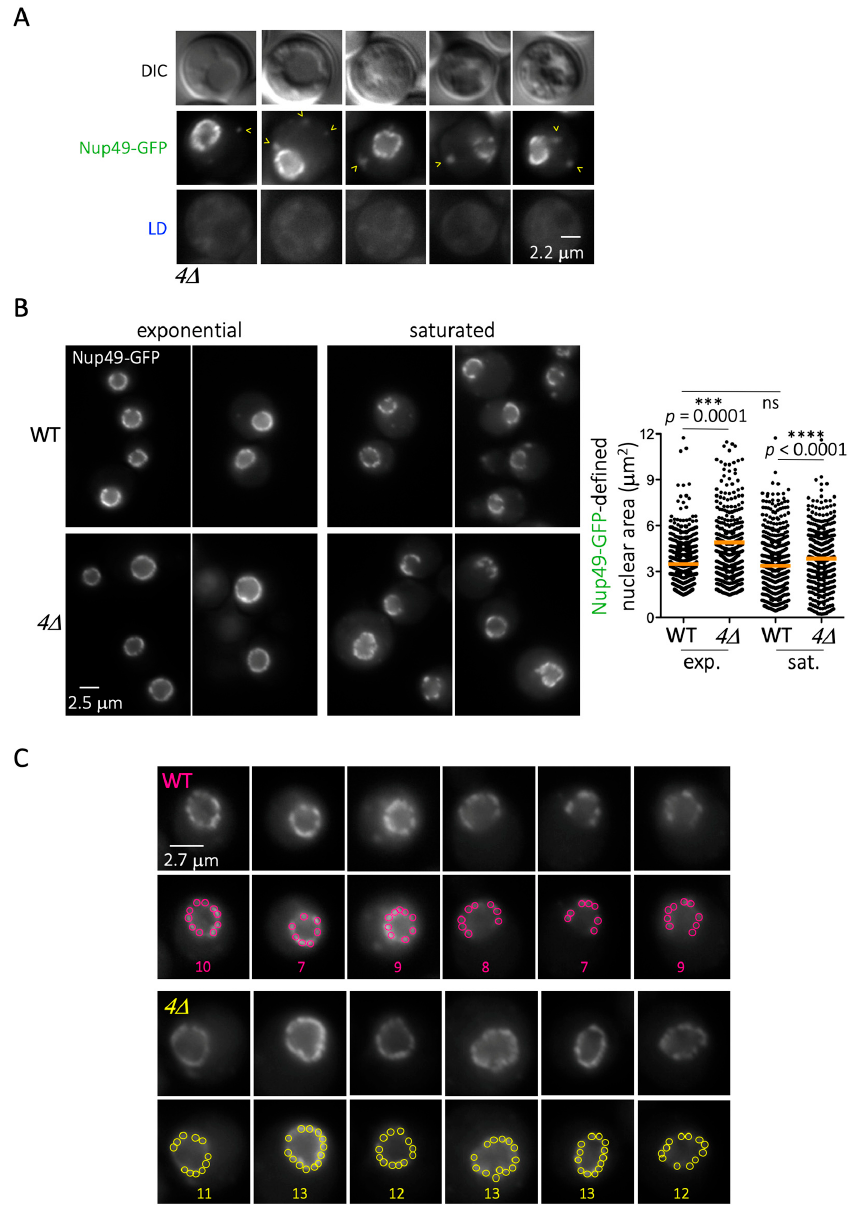
Figure 5. Inability to form LD triggers Nup overload at the nuclear envelope. ( A ) Fluorescence microscopy images of cells that cannot form LD ( dga1 ∆ lro1 ∆ are1 ∆ are2 ∆ , simplified as 4 ∆ ) in which Nup49 has been tagged with GFP. ( B ) left: Fluorescence microscopy images of WT and 4 ∆ cells in which Nup49 has been tagged with GFP, grown either to exponential phase or to saturation. right: Plot of the sizes of individual nuclear areas as defined by the Nup49-GFP rim for each strain for the indicated growth set-ups. Two independent experiments are included per condition in the plot. At least 300 cells were analyzed per condition and experiment. The orange bar indicates the mean of the population. The p values refer to the statistical significance of the difference of the means by t -test. ( C ) Images of individual nuclear rims of both WT and 4 ∆ cells from saturated cultures at the central plane only. For each strain, the upper row corresponds to the unprocessed image, while the lower row shows that same image, to which colored circles have been superimposed. Each circle comprises an NPC cluster, as identified following the directives presented in [34,35,59]. The numbers indicate the number of individual clusters identified for each nuclear